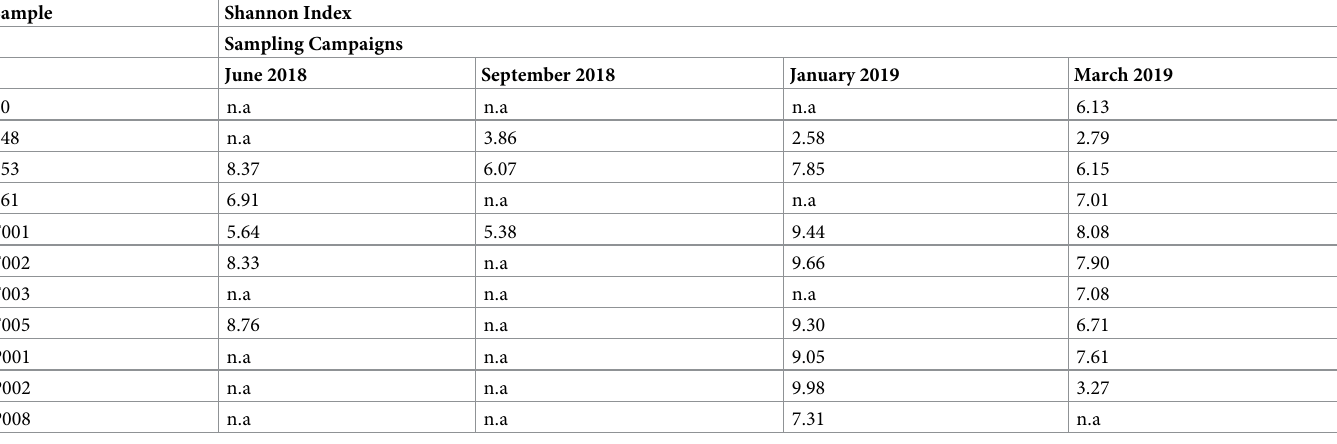
n.a. represents not available